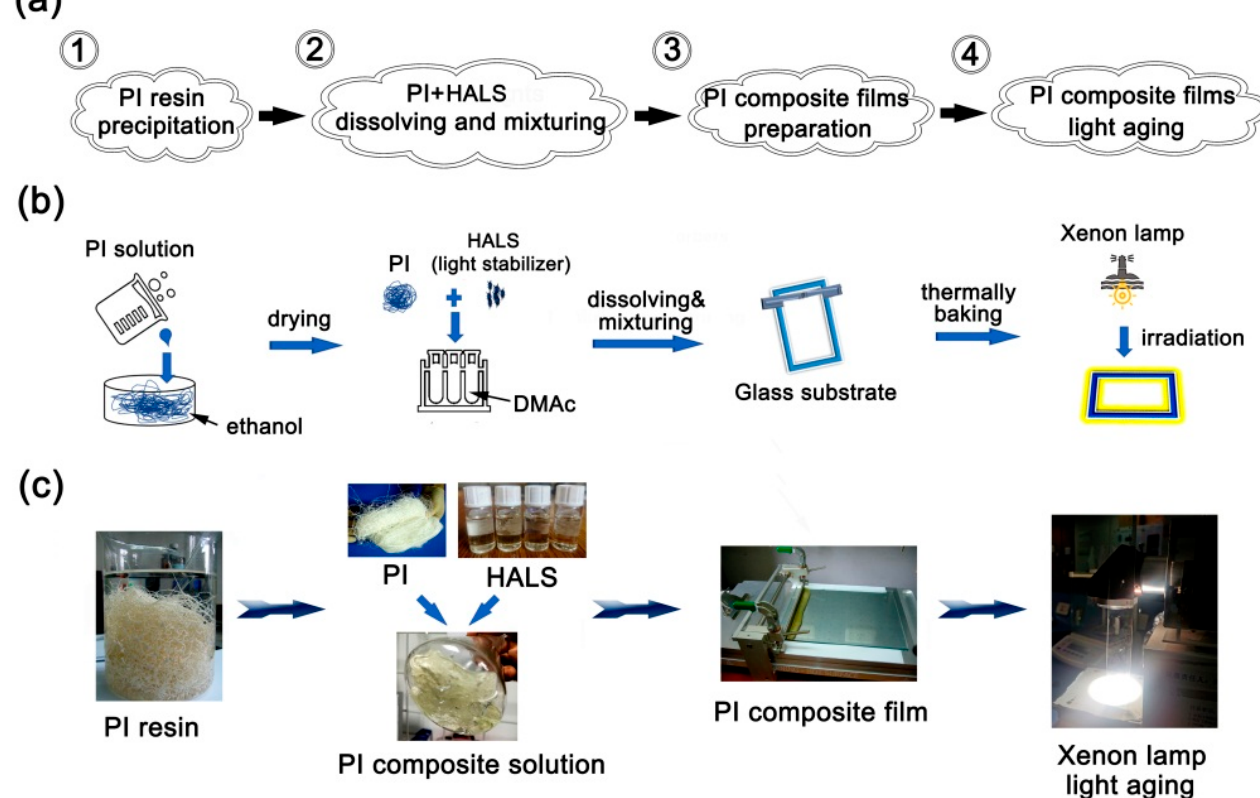
Figure 6. Experimental design and property evaluation of the CPI films. ( a ) flowchart; ( b ) vectorgraph; ( c ) experimental diagram.